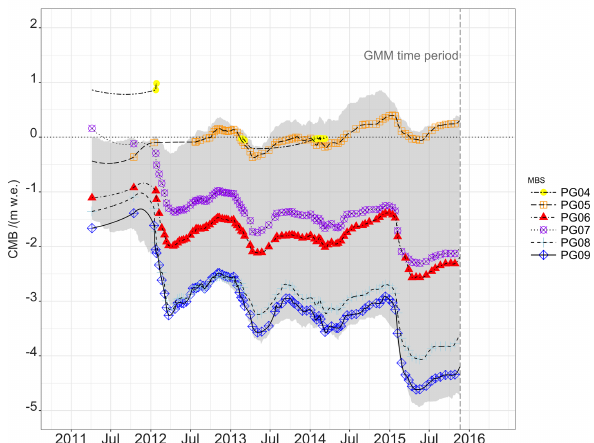
Figure 9. Shown is the cumulative mass balance in mw.e. (water equivalent) measured at the validation mass balance stake transect PG1 x on the Fourcade Glacier, Potter Peninsula, during the time period November 2011 to May 2016. The location of the individ- ual stakes is shown in Fig. 1. The lines are interpolation lines be- tween observation points. The grey shade indicates the spread of the GMM-simulated cumulative mass balance at the stake locations PG15 to